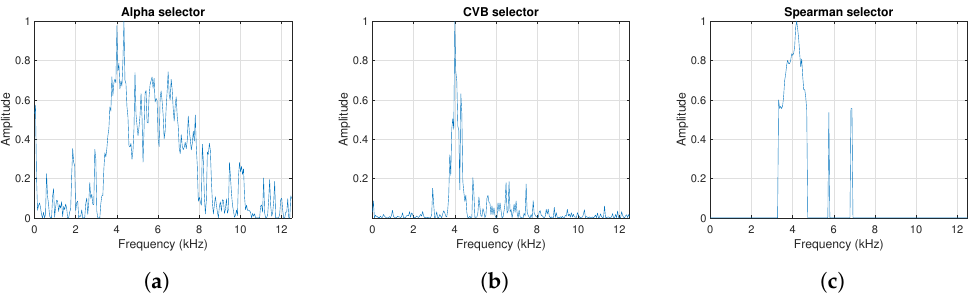
Figure 22. IFB selectors for the simulated signal s 3 . ( a ) Alpha selector. ( b ) CVB selector. ( c ) Spearman selector.